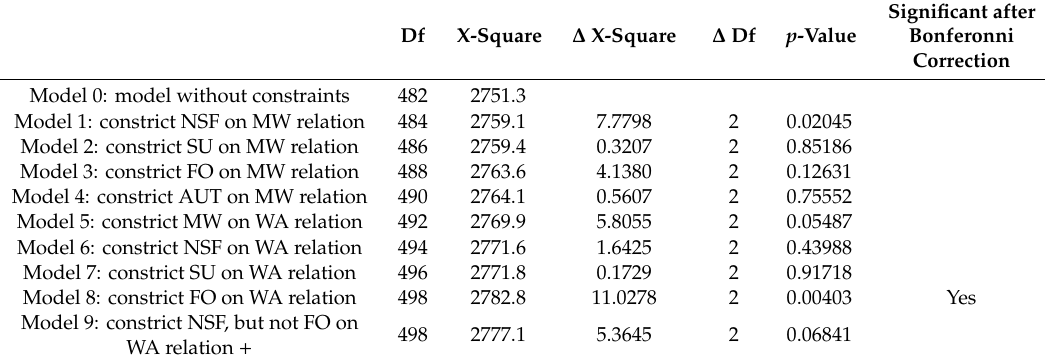
Table 3. Test of age interaction.